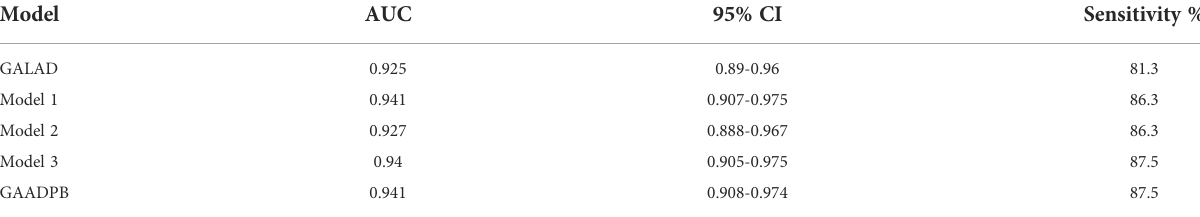
TABLE 3 Models performance for discriminating HCC (n = 80) and CLD (n = 139) (Speci fi city=90%). Model